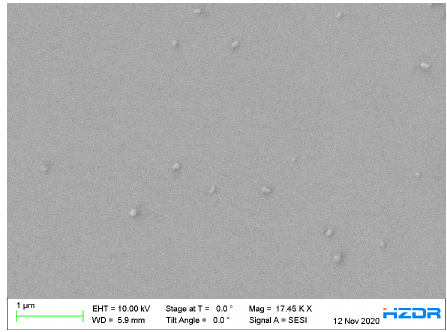
Figure 13. SEM image of p-GaN:Cs on silicon photocathode (sample B2), thermally cleaned at 500 °C and activated with cesium for five cycles.